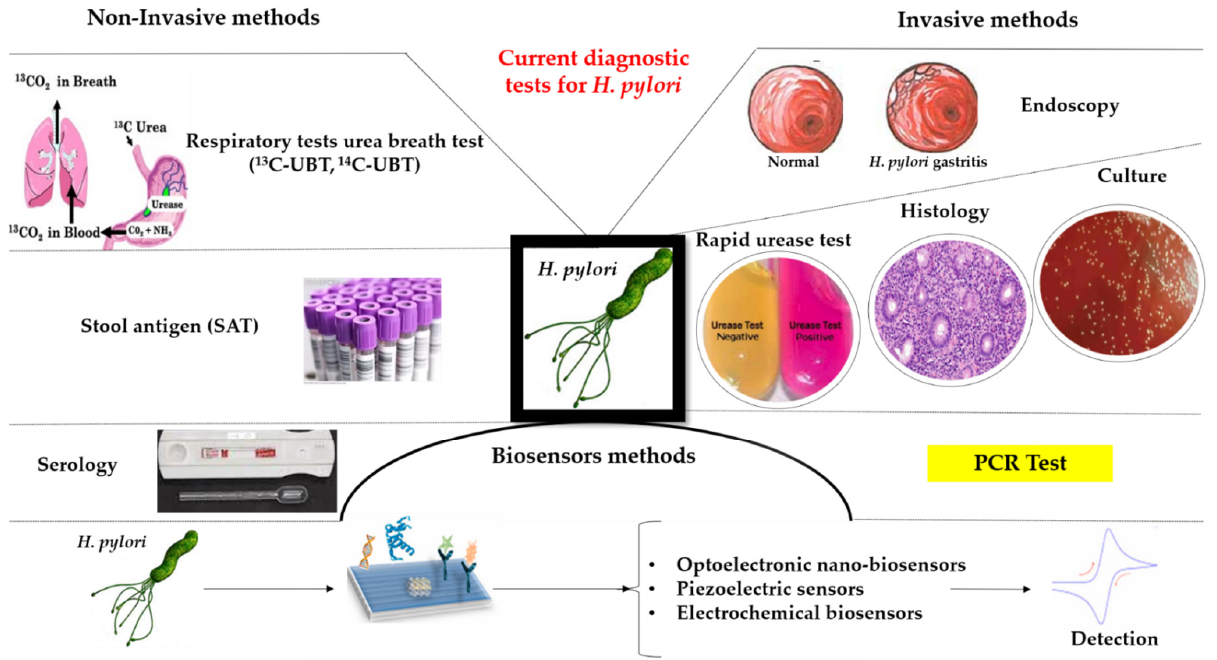
Figure 1. Invasive and noninvasive diagnostic tools for H. pylori .